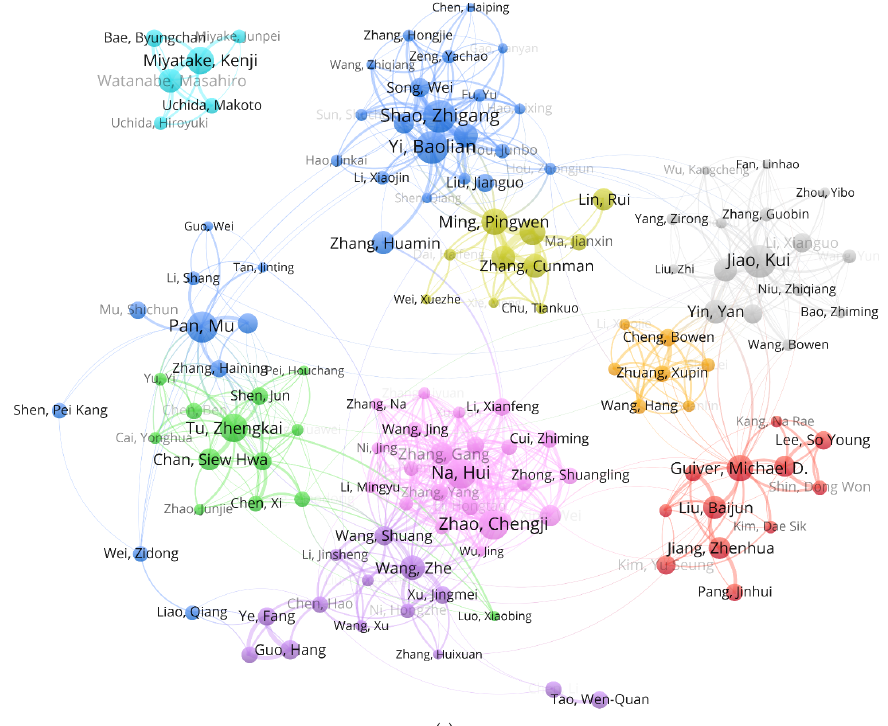
Figure 4. Collaboration network map of authors ( a ) the overall network ( b ) the network of main authors ( c ) the collaboration network of prolific authors.